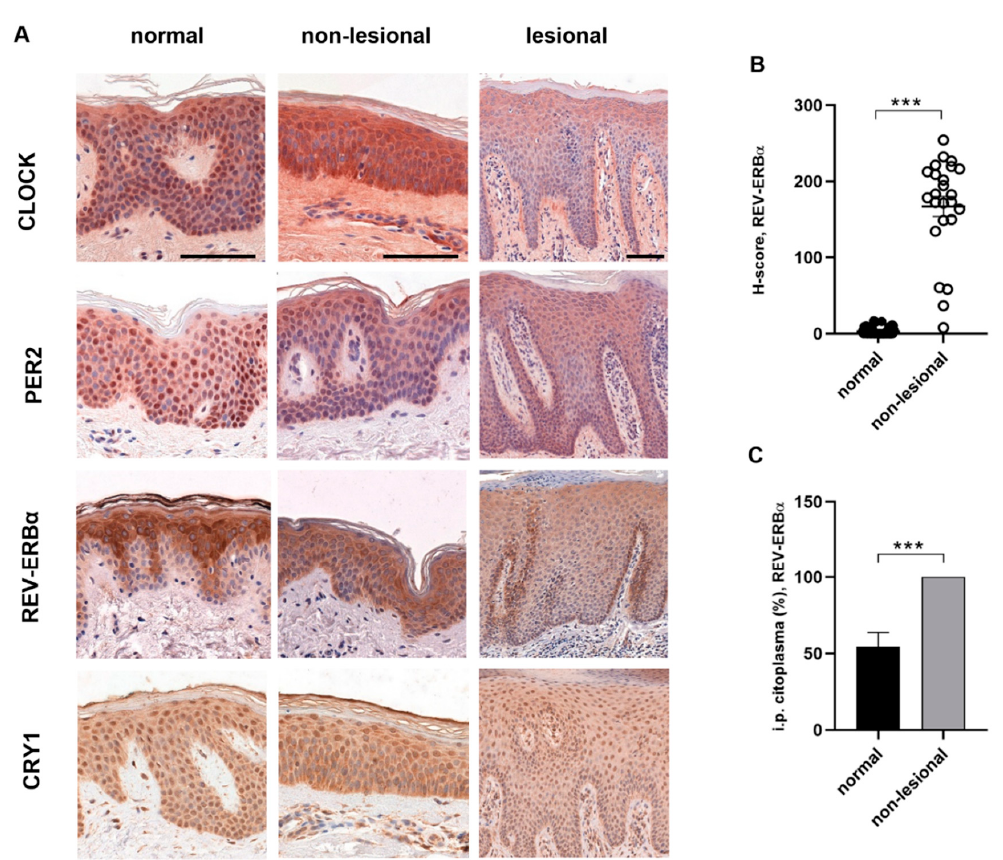
Figure 2. Immunohistochemistry staining of circadian proteins in human skin: ( A ) representative DAB-stained skin sections at 06:00. Normal and non-lesional skin samples at 400 × magnification (scale bar = 100 µ m) Lesional skin at 200 × magnification (scale bar = 100 µ m). ( B ) H-scores (the percentages of cells at each staining intensity level) for nuclear REV-ERB α expression in normal and non-lesional epidermis: *** p < 0.0005. Data are presented as the means ± SEM. ( C ) Cytoplasmic staining (ratio of the positive cells) of REV-ERB α in normal and non-lesional epidermis: *** p < 0.0005. Data are presented as the means ±